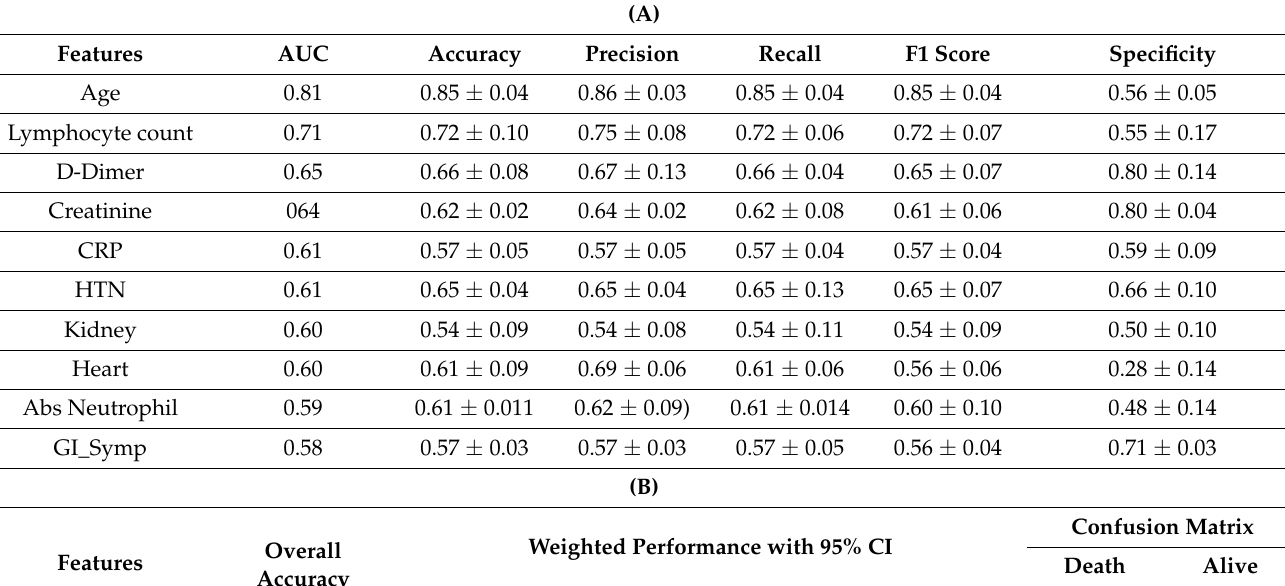
technique development and validation. Table 4. Comparison of the average performance matrix and confusion matrix from five-fold cross-validation for ( A ) Individual top 10 feature, ( B ) Combined top 1 to 10